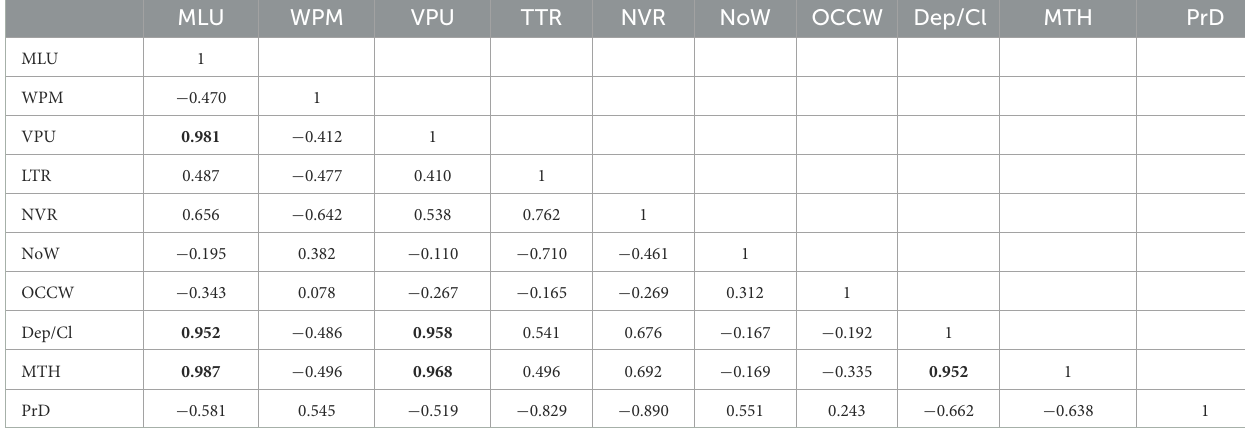
TABLE 5 Correlations between linguistic variables of narrative discourse production across elicitation